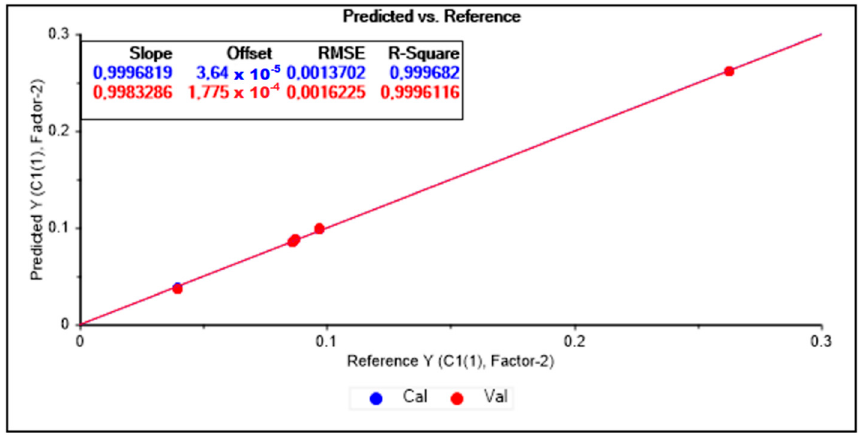
Figure 6. Correlation dependence of reference (coulometric titration) and predicted concentration (electrode potential) obtained by PLS method for effervescent tablets dissolved in acetate buffer.